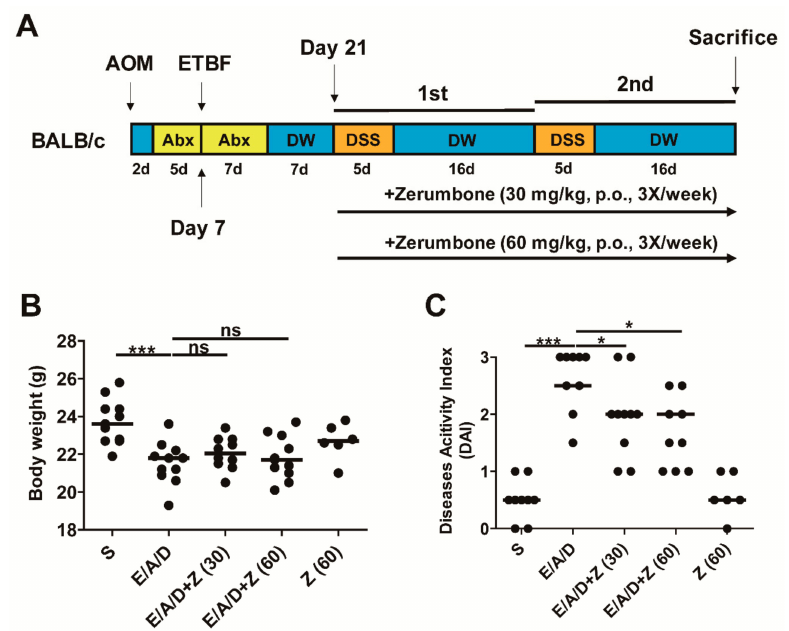
Figure 1. Experimental scheme and e ff ects of zerumbone on body weight and the disease activity index in enterotoxigenic Bacteroides fragilis (ETBF) / AOM / DSS mice. BALB / c mice were given a single intraperitoneal injection of AOM (10 mg / kg) and provided drinking water ad libitum containing clindamycin / gentamicin for 5 days (yellow box). ETBF was orally inoculated and the antibiotic cocktail was continued for an additional 7 days (yellow box). Seven days later, BALB / c mice were subjected to two cycles of 1% DSS (5 days per cycle, orange boxes) and distilled water (DW; 16 days per cycle, blue boxes). During the two DSS cycles, BALB / c mice were given zerumbone (30, 60 mg / kg, p.o., three times a week). The total period of the experiment was 9 weeks. ( A ) Experimental design of the ETBF / AOM / DSS-induced tumorigenesis model. ( B ) Body weight. ( C ) Disease activity index (DAI). Body weight and DAI were measured at the last day of ETBF / AOM / DSS-treated experiments. S, sham control; E, ETBF; A, AOM; D, DSS; Z (30), Zerumbone (30 mg / kg) and Z (60), Zerumbone (60 mg / kg). Each dot represents one mouse ( n = 6–12 mice per group). Scatter plot. Horizontal bar, median. * p < 0.05, *** p < 0.001. ns, no statistical